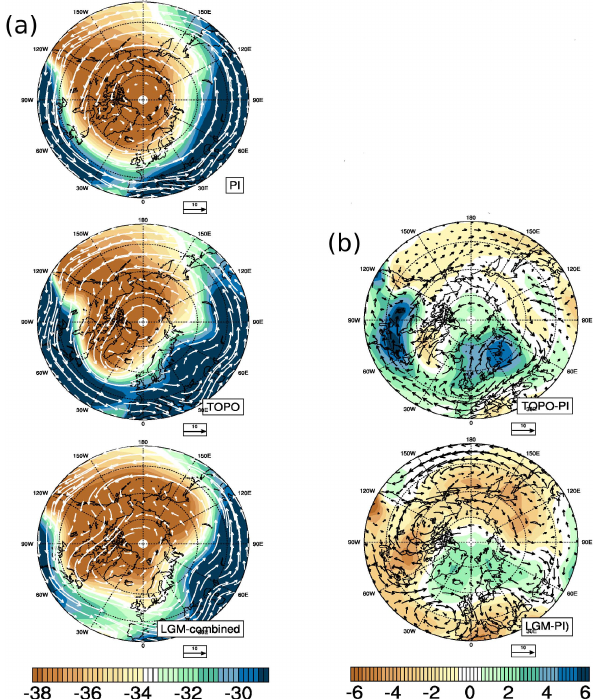
Fig. 12. As Fig. 11, but for JJA